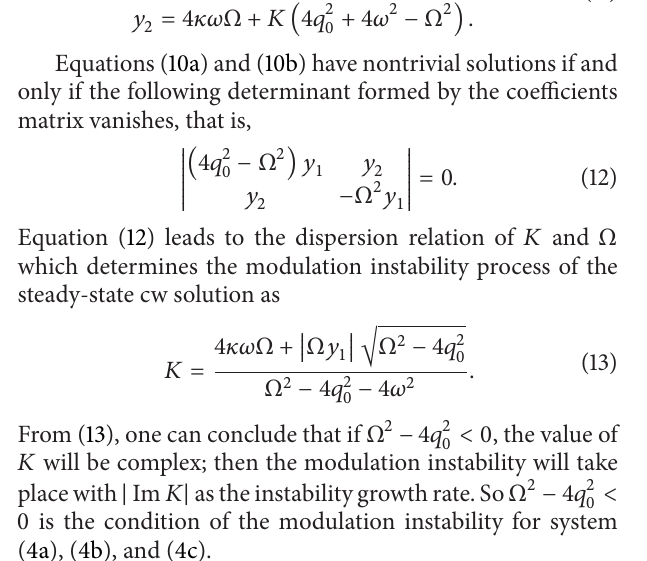
perturbations, and 𝐾 is the real disturbance wave